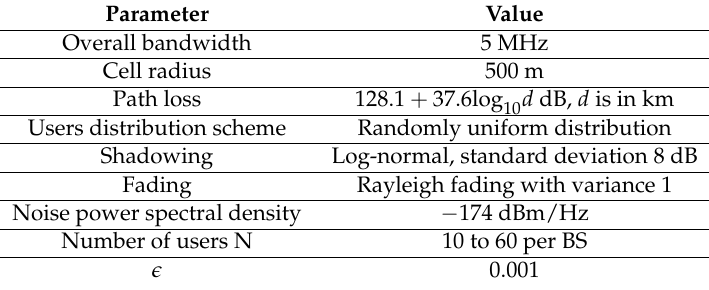
Table 2. Simulation